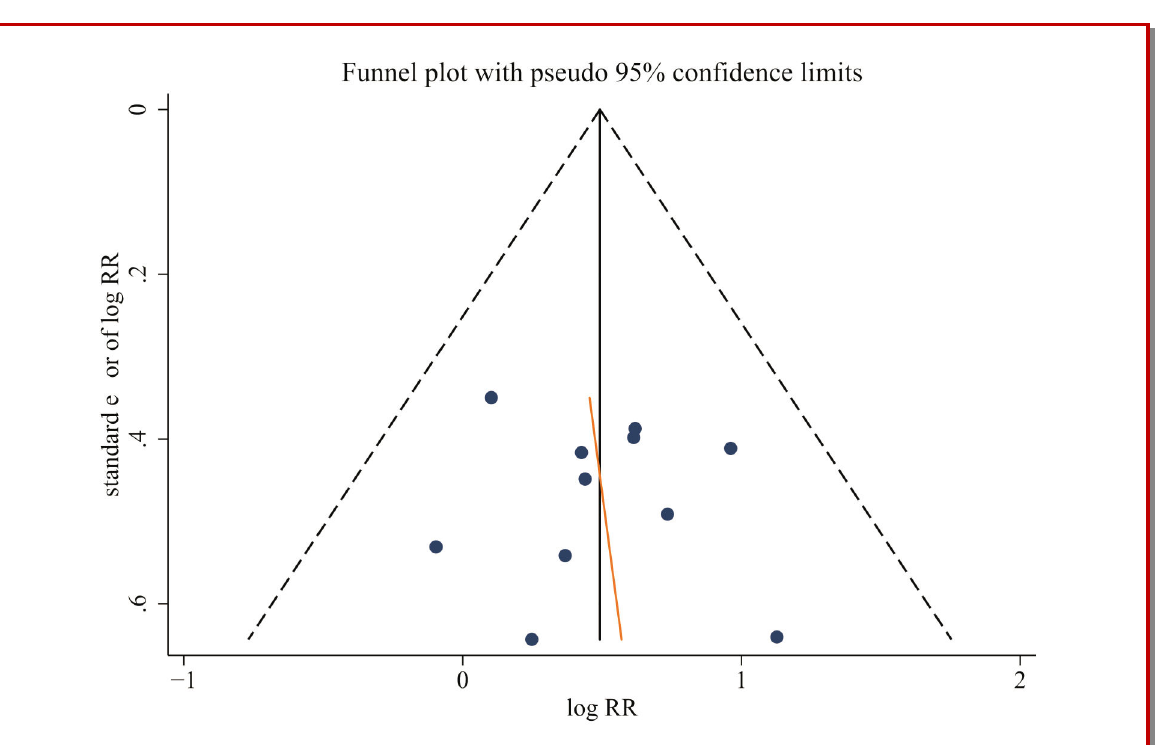
Figure 8: The funnel plot for live birth rate comparisons in active immunotherapy